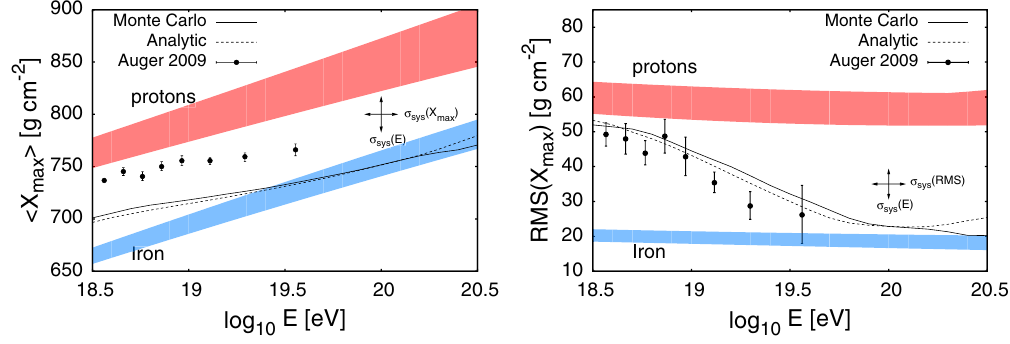
Figure 3. Composition dependence (cid:2) X max (cid:3) and RMS( X max ) plots comparing analytic and Monte Carlo based results. For these results a spectral index (cid:4) = 1.8 and a maximum source energy of E Fe,max = 10 21 eV have been used.